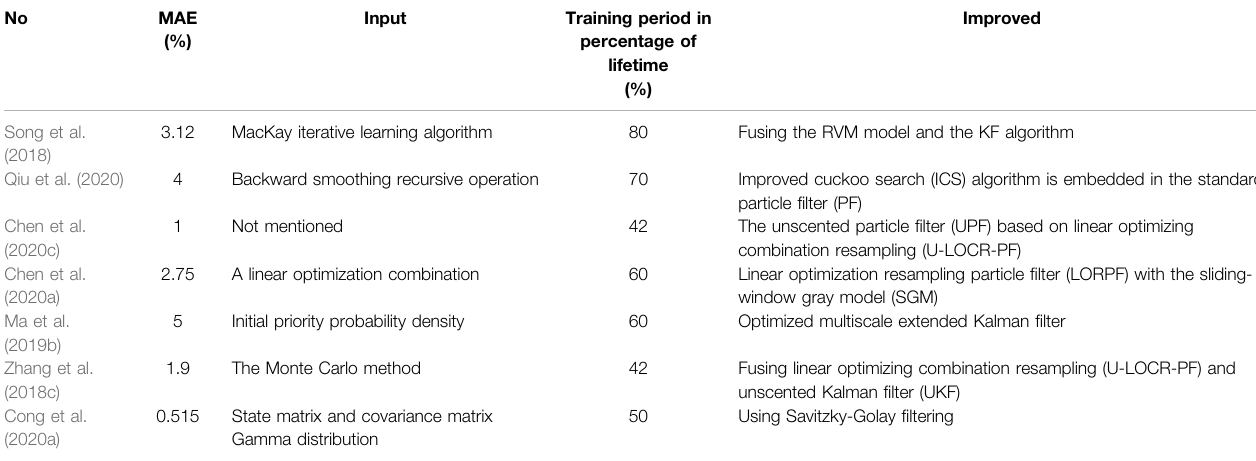
TABLE 2 | The comparison of adaptive fi lter method